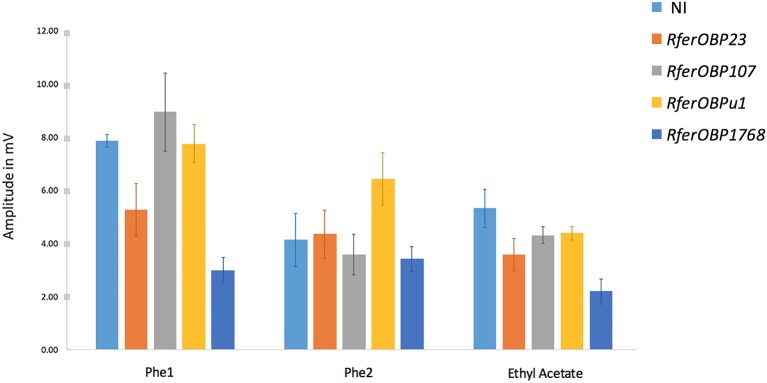
Comparison of EAG responses from treated and non-treated samples to three different stimuli, as represented as three groups. The values represent the amplitudes of signals in mV, and the error bars represent the SEM. The detailed statistical analysis is provided in Table S4.